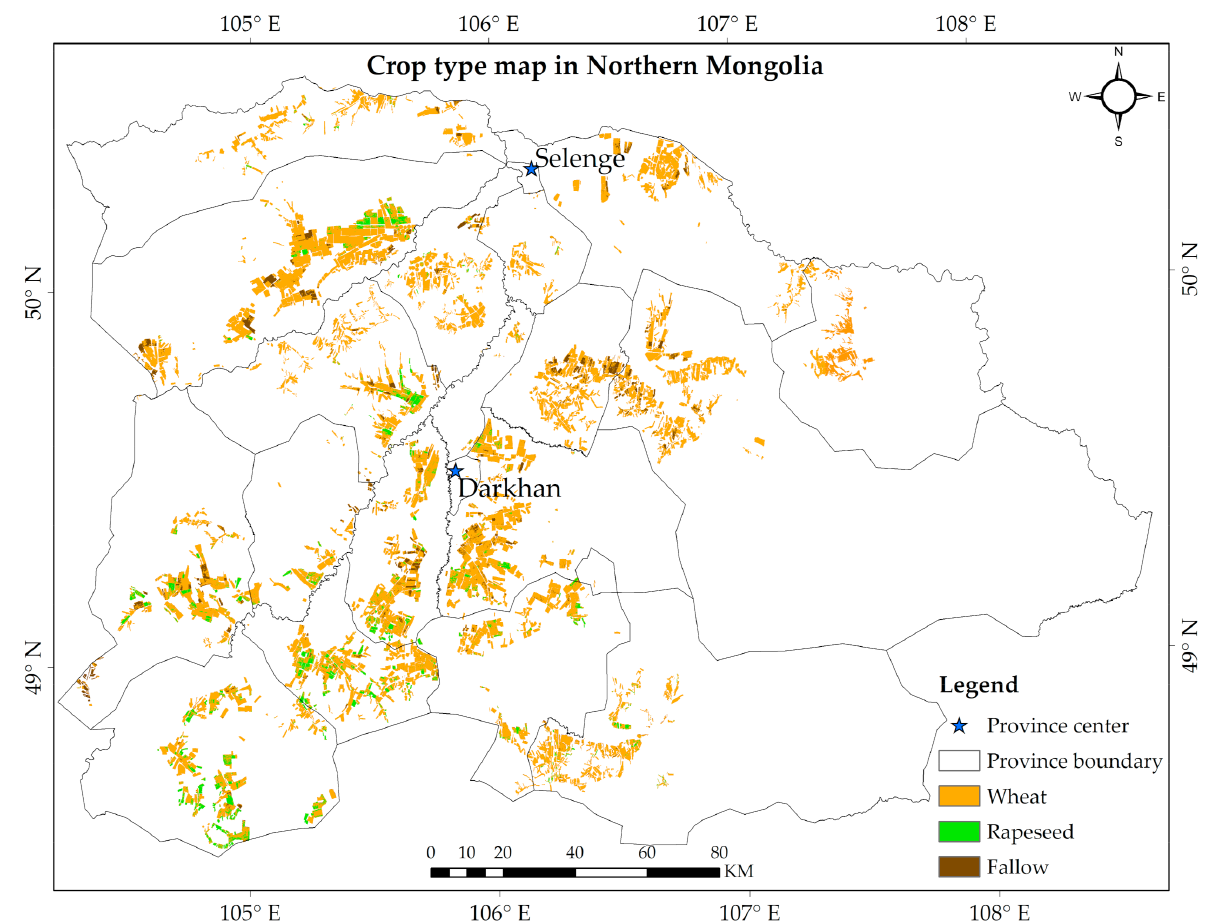
Figure 10. Crop-type distribution in Selenge and Darkhan provinces of